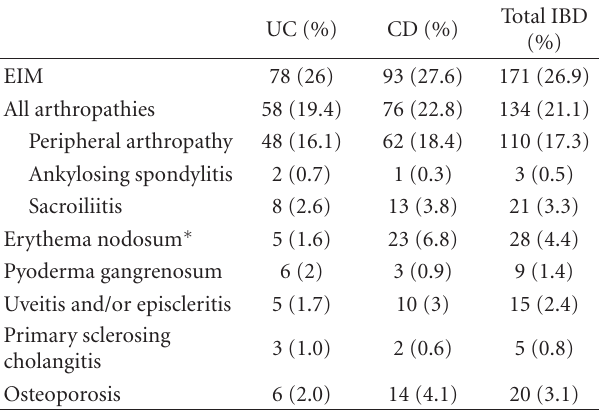
Table 2: Extraintestinal